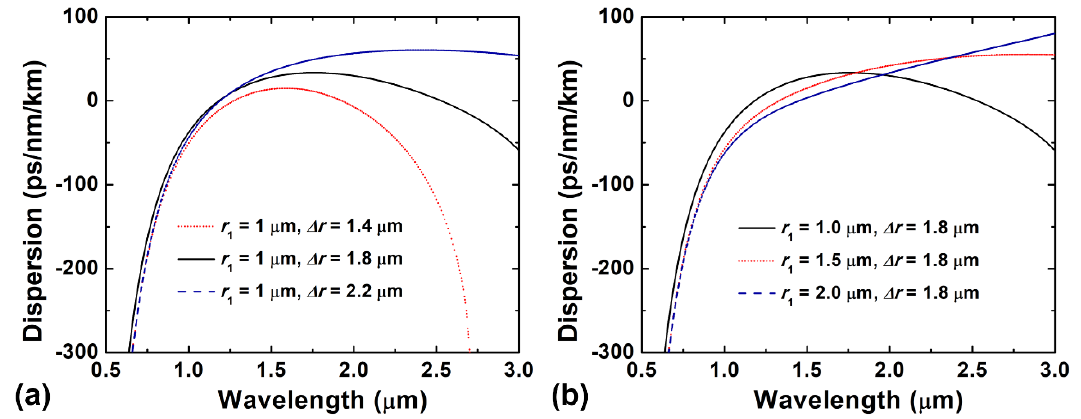
Figure 3. Dispersion-wavelength curves for different ( a ) ring width ( Δ r ) and ( b ) fiber inner SiO 2 radius ( r 1 ).